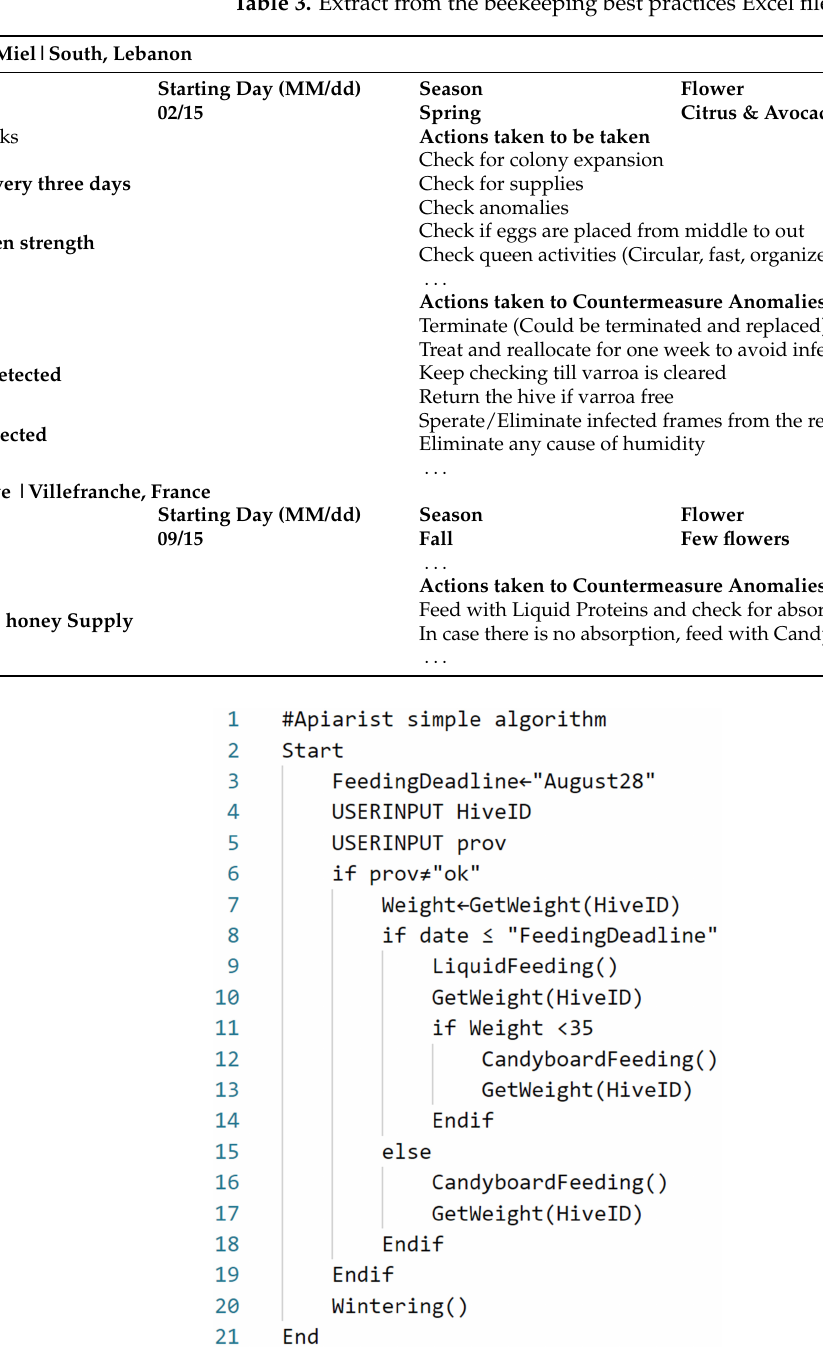
Figure 5. Simple Pseudo Code, provided by Connecthive, France.